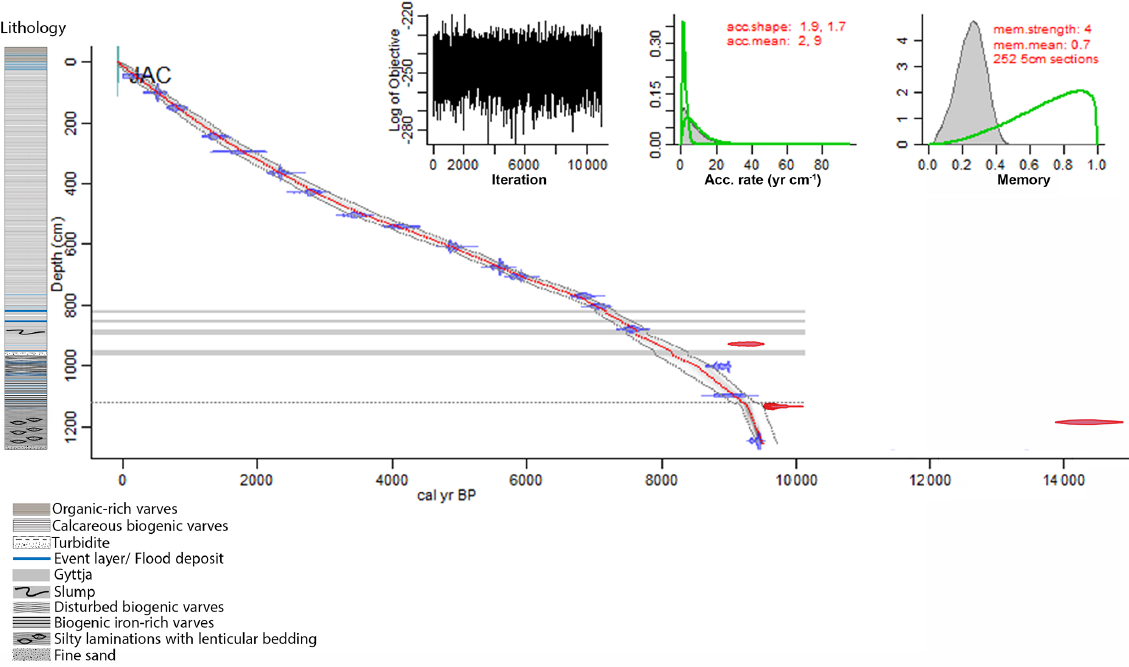
Figure 2. Age–depth model and lithology of Lake Jaczno. The red line is the modeled chronology using bacon (Blaauw and Christen, 2011; Blaauw et al., 2020); the excluded outliers are shown in red. The dotted grey lines indicate the 95% (2 σ ) probabilities. The horizontal grey areas indicate event layers ( > 3cm) excluded from the model. The horizontal dashed line marks the boundary of a higher sedimentation rate (model parameter). The upper left inset shows the log objective vs. MCMC iteration that indicates a stationary distribution. The middle and right insets indicate the distributions (prior in green, posterior in grey) for the accumulation rate and the memory,